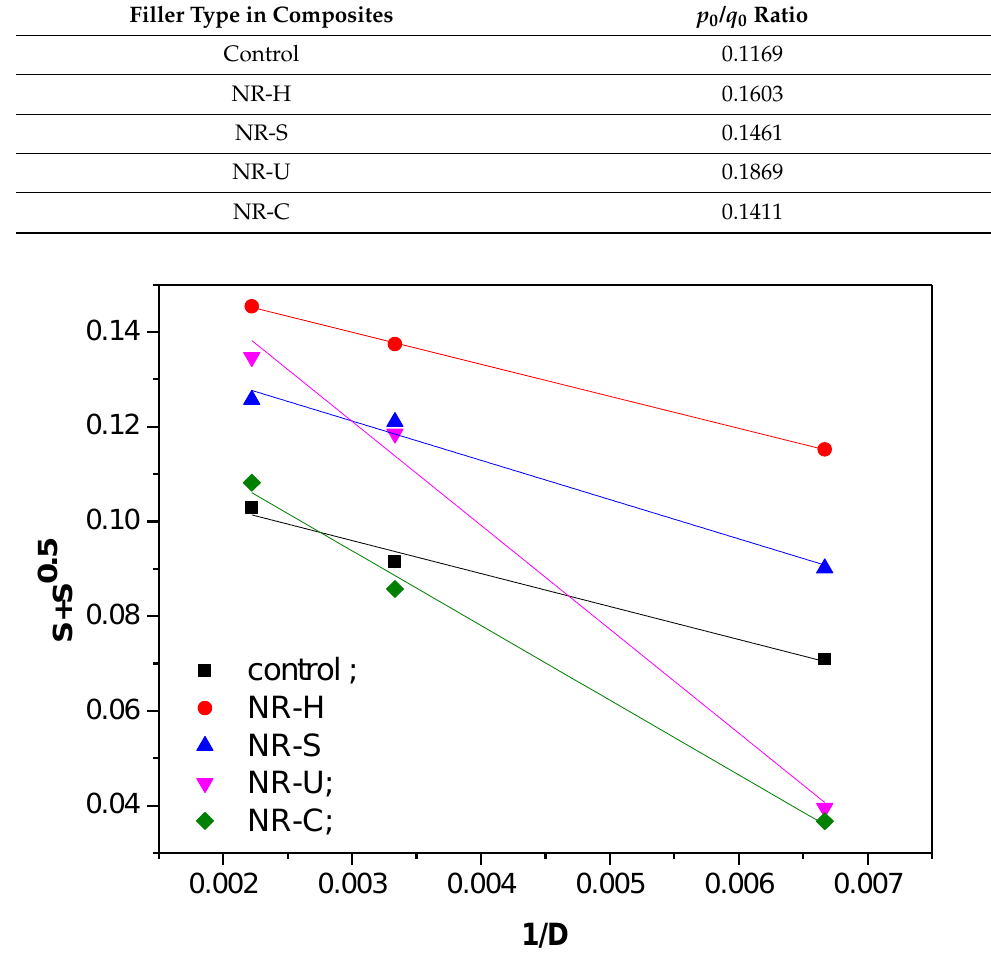
Figure 3. Charlesby-Pinner plots of composites. Table 6. p 0 / q 0 ratio for composites.